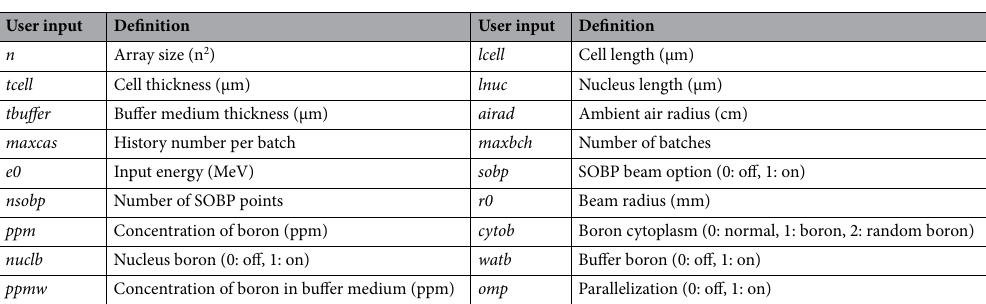
Table 1. Definition of user inputs for the cell generator program for simulation of